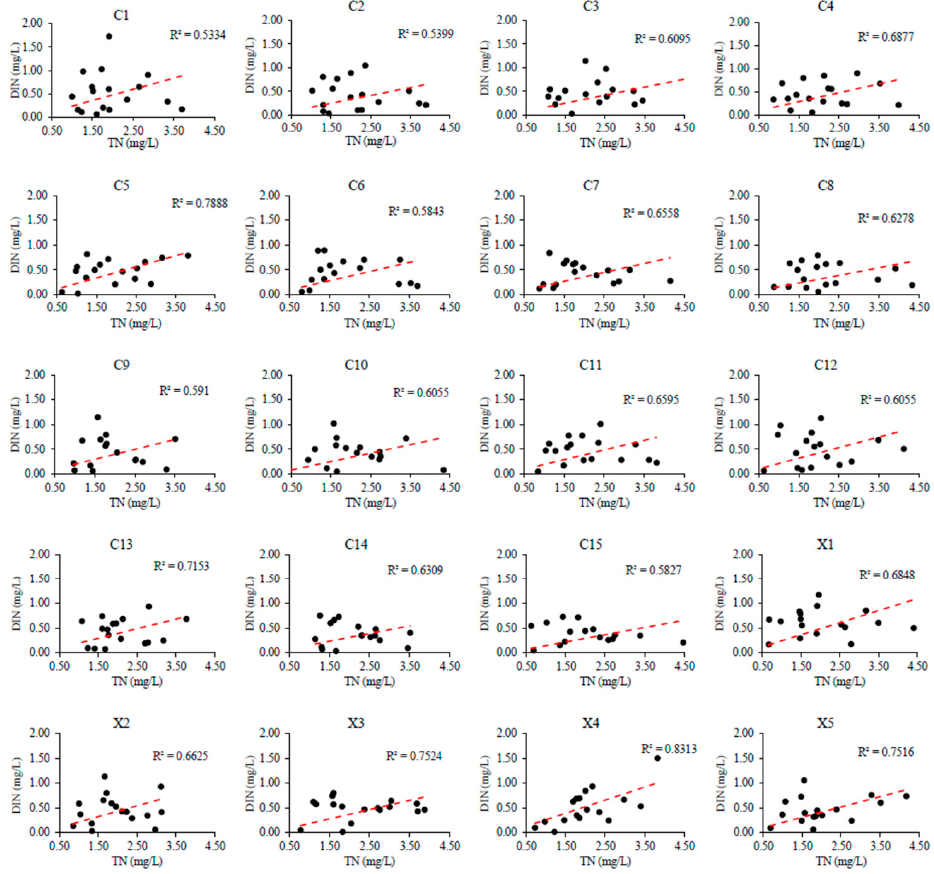
Figure 9. The relationships between DIN and TN at 20 stations from June 2013 to August 2014 derived from the field observations at station X1 to X5 and C1 to C15. Table 3. The slope of fitted linear relationship between DIN and TN at 20 stations from June 2013 to August